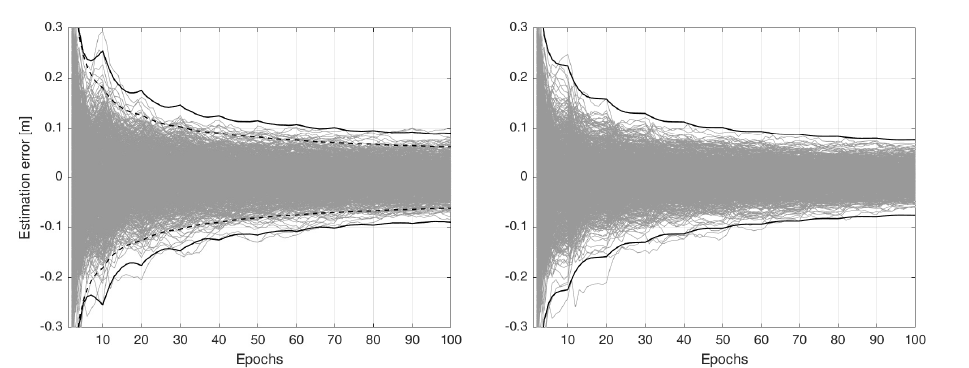
ˆ b = 1, . . . ,100) of Example 2 h h ( h − |